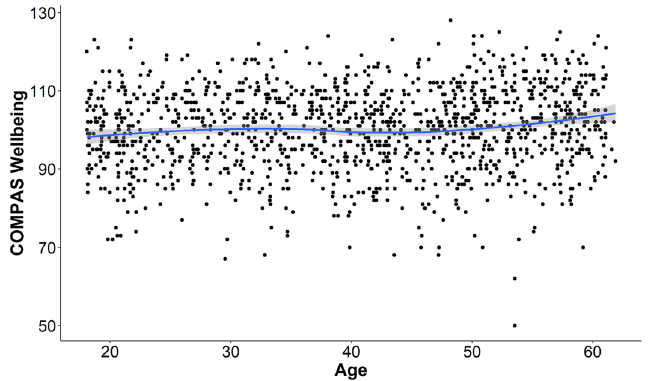
Figure 1. Scatterplot and loess line showing relationship between age and mental wellbeing. The trend line shows a slight cubic increase in wellbeing, with an initial increase to mid-thirties followed by a dip between 40 and 50 years, followed by a final increase to age